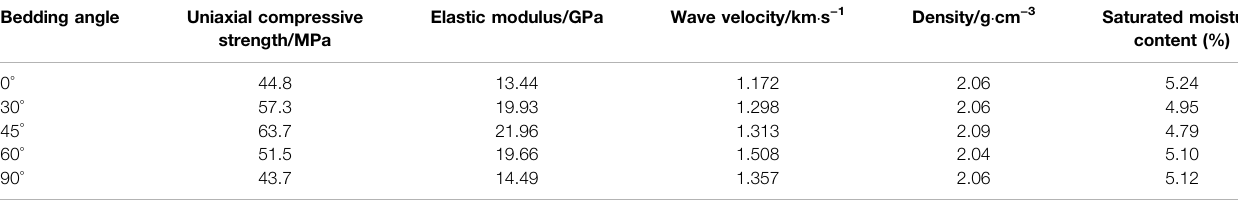
TABLE 3 | Average value of key parameters of anchored rock samples. Bedding angle